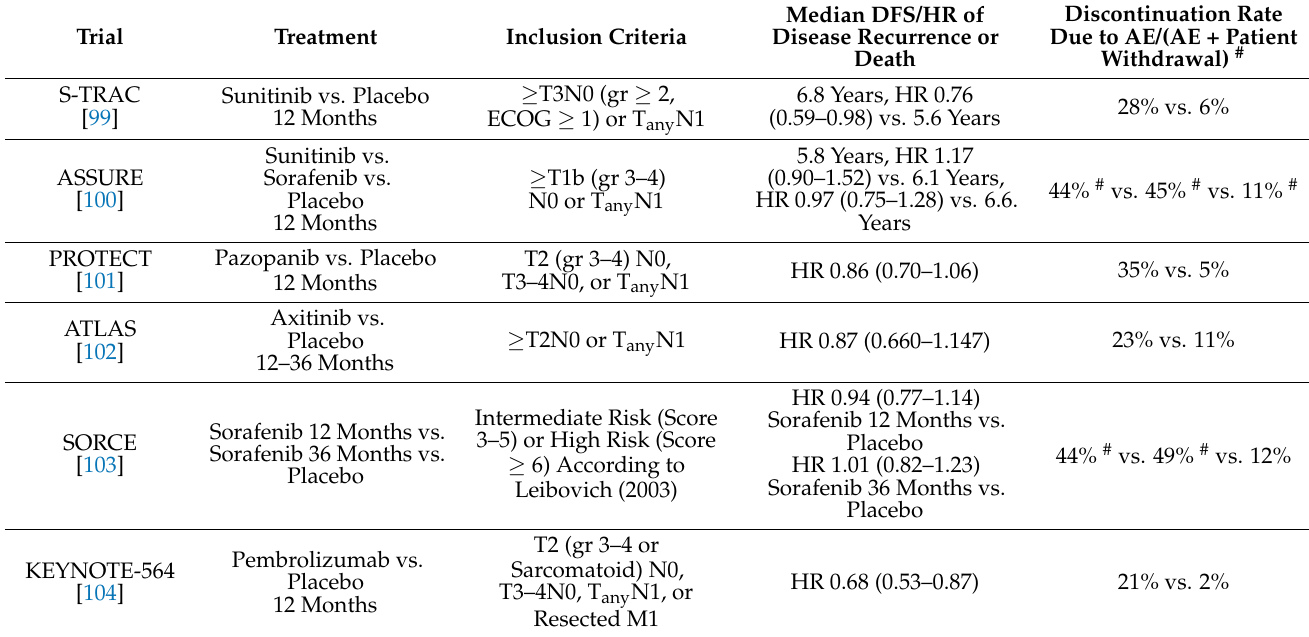
Table 2. The results from phase III randomized adjuvant TKI and ICI trials in